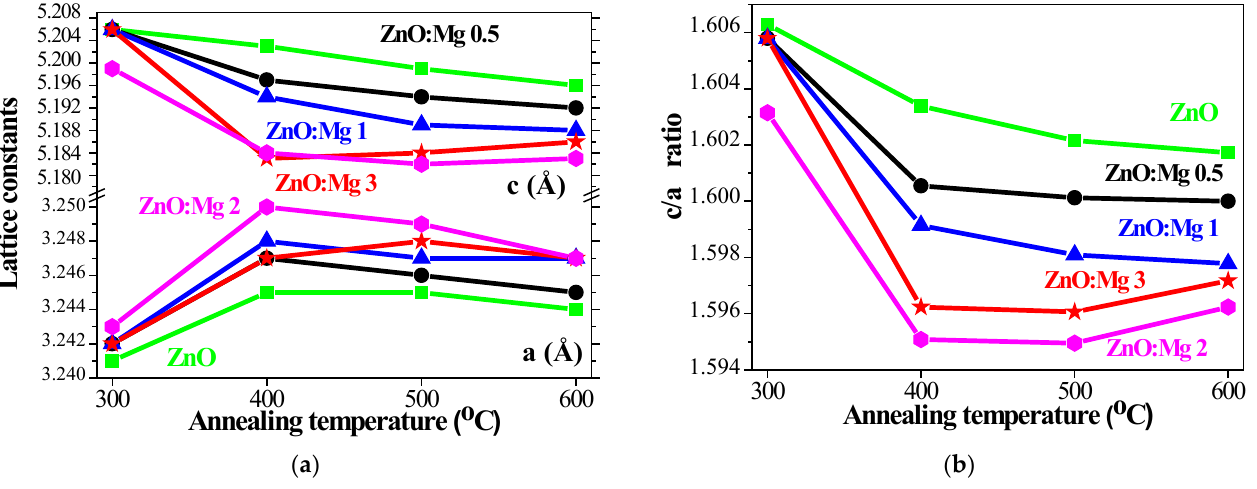
Figure 6. Estimated values of ( a ) the lattice parameters c and a and ( b ) the c/a ratio as a function of the annealing temperature of ZnO and ZnO:Mg films.